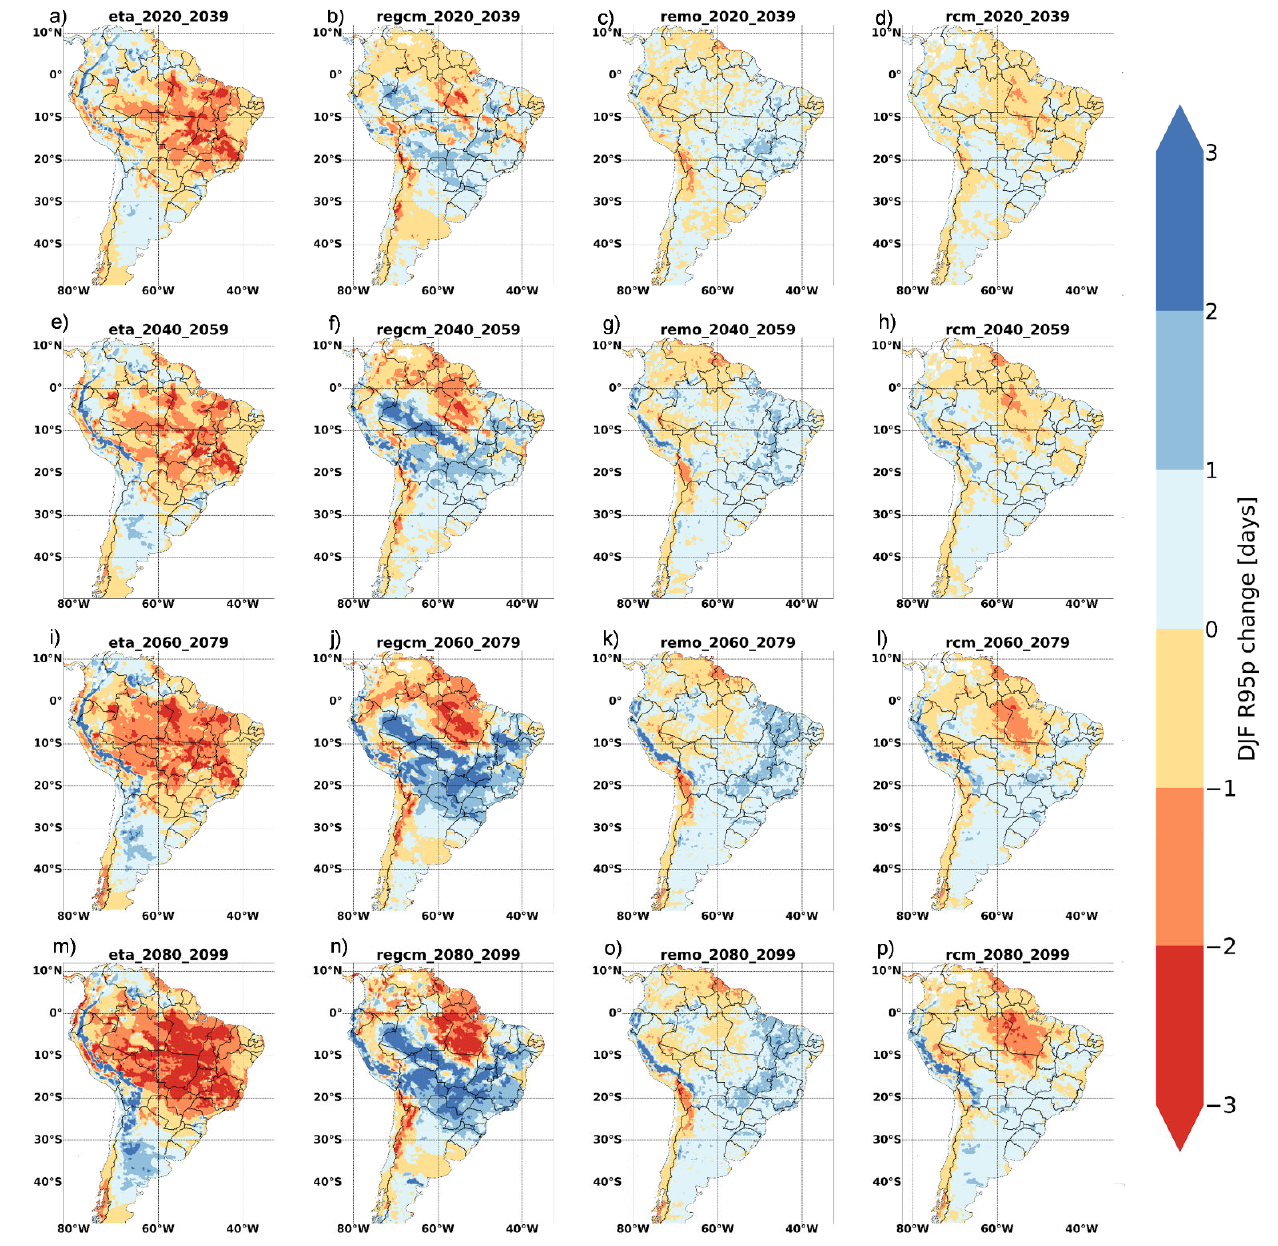
Figure 7. Changes projected to R95p (days) during austral summer computed from each RCM ensemble (Eta, RegCM, and REMO) and 3RCMs ensemble (right column) and considering four time-slices: ( a – d ) 2020–2039, ( e – h ) 2040–2059, ( i – l ) 2060–2079, and ( m – p ) 2080–2099. R95p in all time-slices is obtained with the same threshold (P95) calculated for the 1995–2014